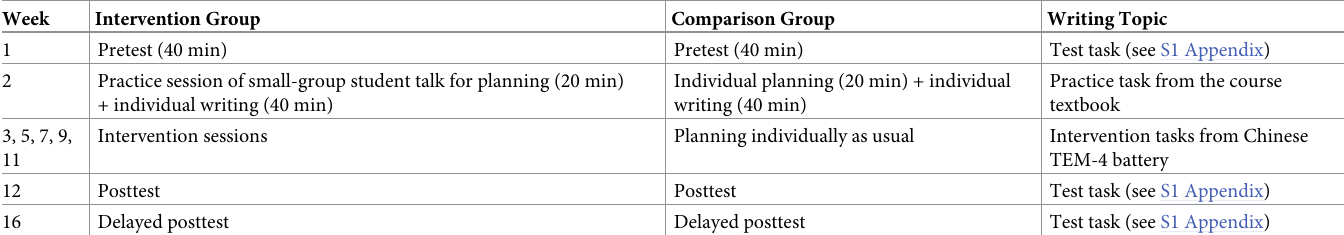
Table 1. Procedures of the